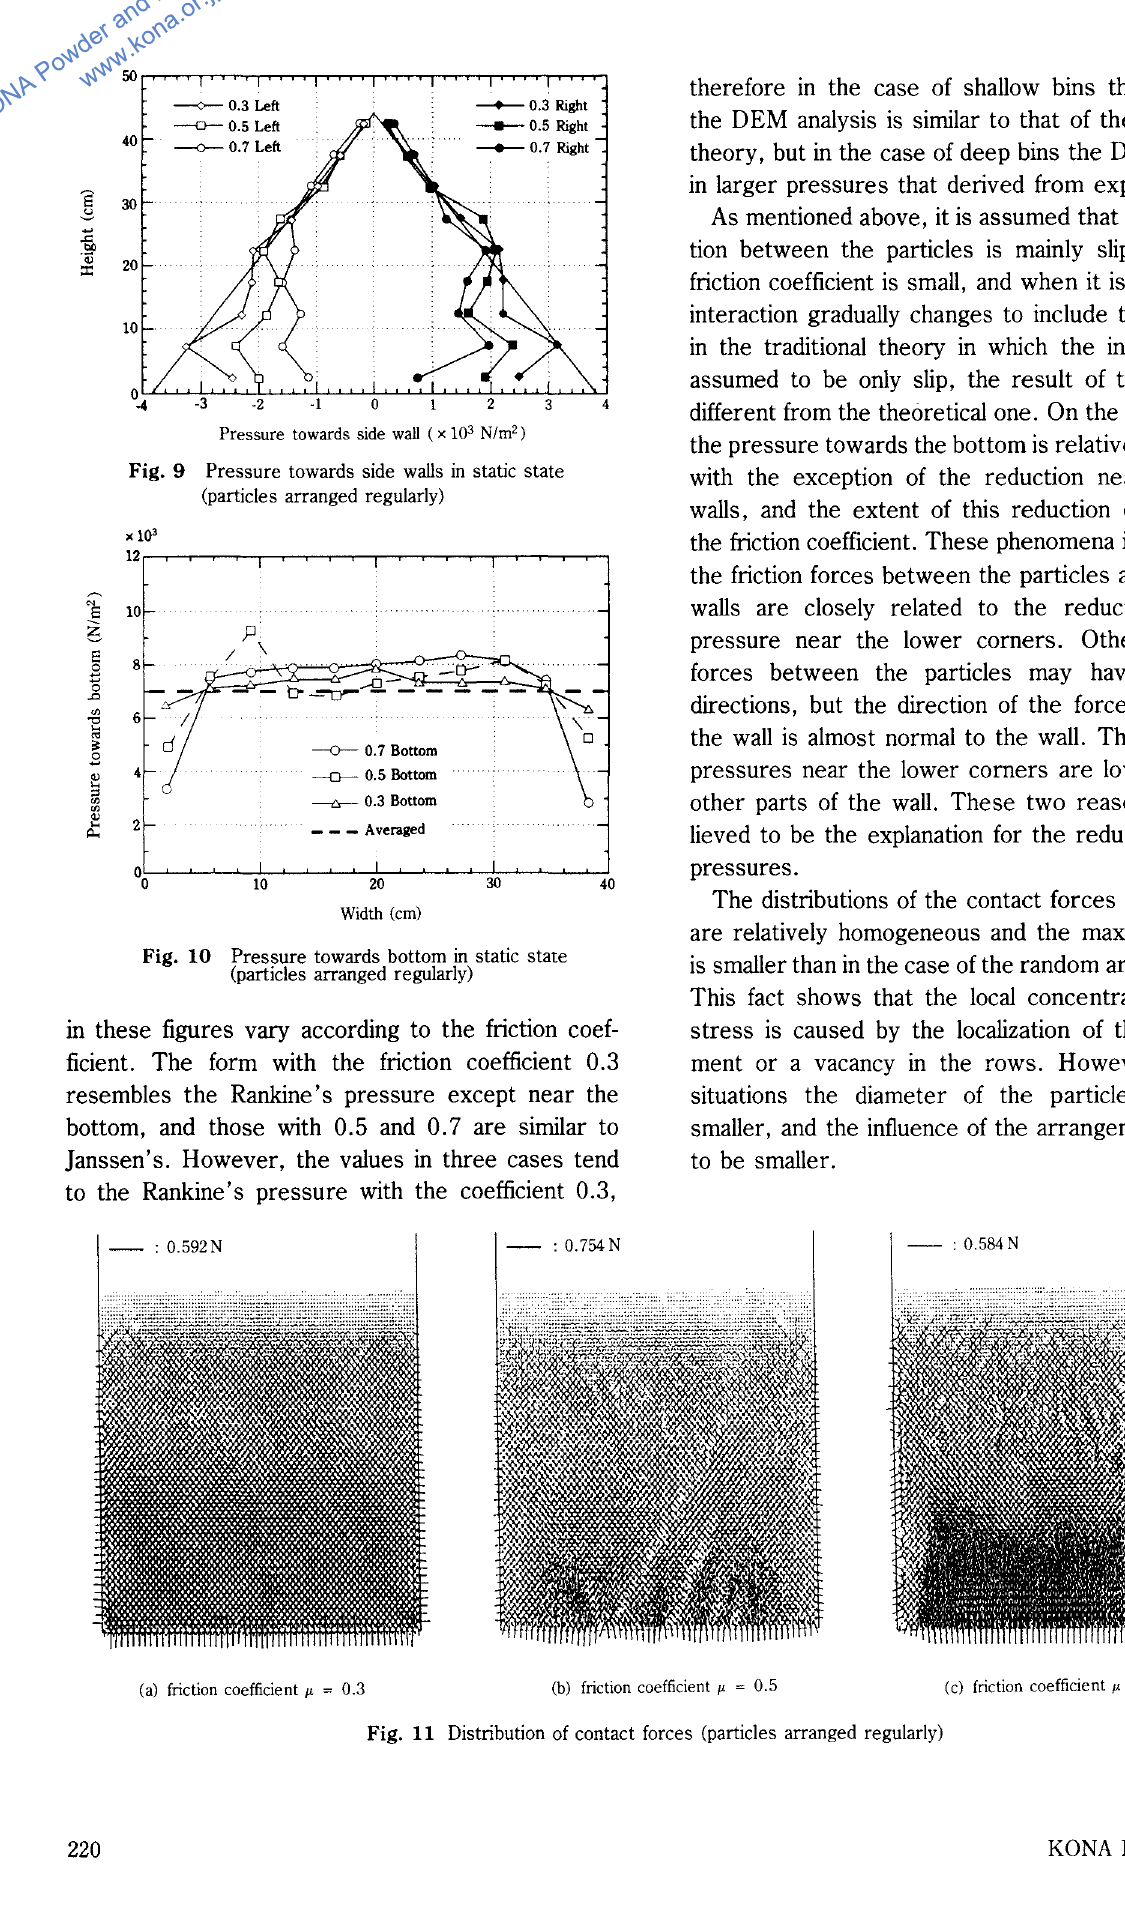
Fig. 11 Distribution of contact forces (particles arranged regularly)